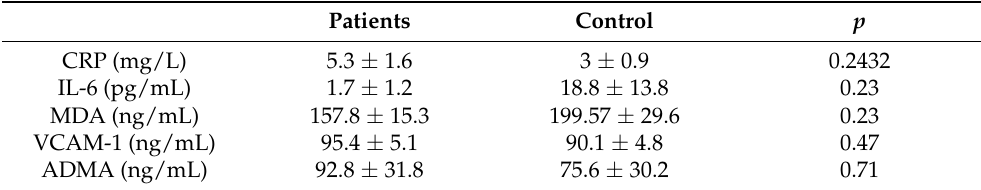
Table 6. Inflammation, oxidative stress, and endothelial dysfunction markers (mean ± SEM).